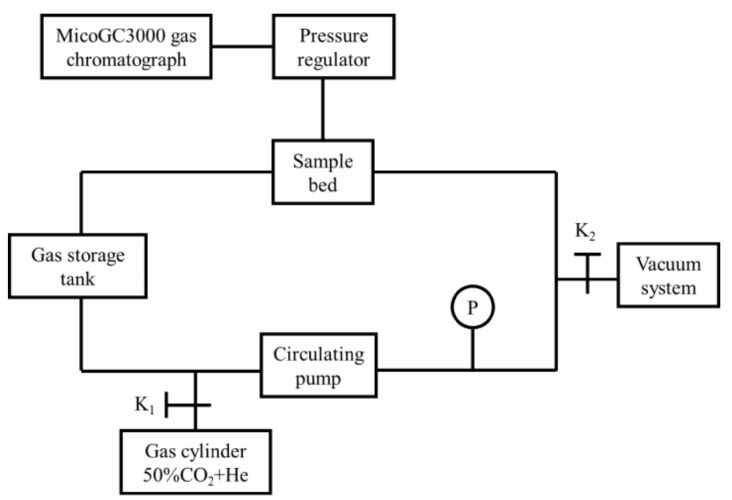
Figure 1. Schematic diagram of hydrogen permeation rate test